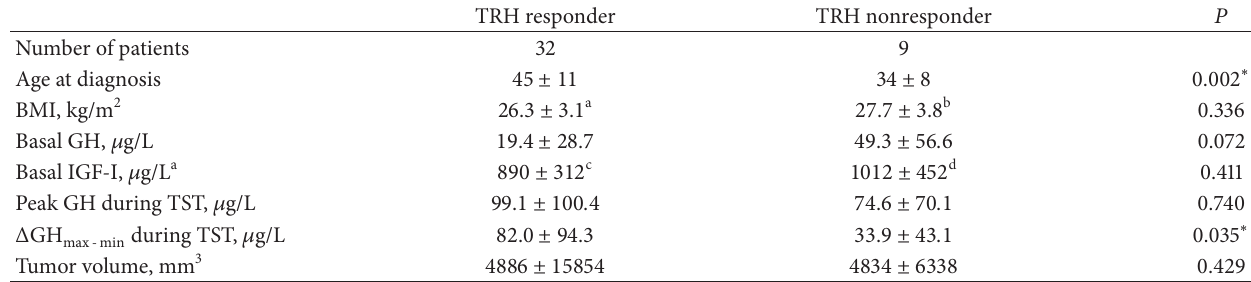
Table 1: Baseline characteristics of 41 patients with GH-producing pituitary adenomas according to their response patterns to the TRH suppression test.